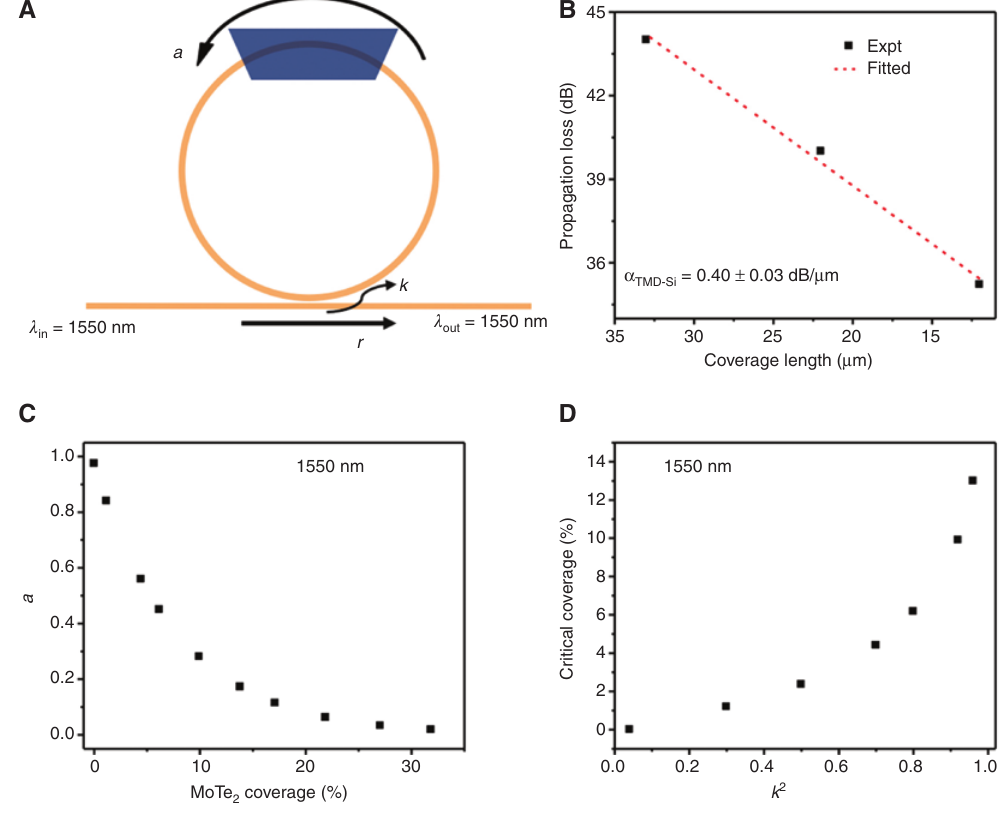
Figure 3: Coupling coefficients for TMD integrated hybrid Si MRR. (A) Schematic representation of MRR showing self-coupling coefficient ( r ), cross-coupling coefficient ( k ), and roundtrip transmission coefficient ( a ), where the ring is partially covered by a MoTe flake. (B) Propagation loss ( α ) for TMD-covered portion of the ring found 2 TMD-Si to be 0.4 dB/ μ m using cutback measurement. (C) Tunability of roundtrip transmission coefficient explains the exponential decrease as a function of flake coverage. (D) Relationship between critical coverage (%) and power coupling coefficient ( k 2 ) assuming lossless coupling ( r 2 + k 2 =